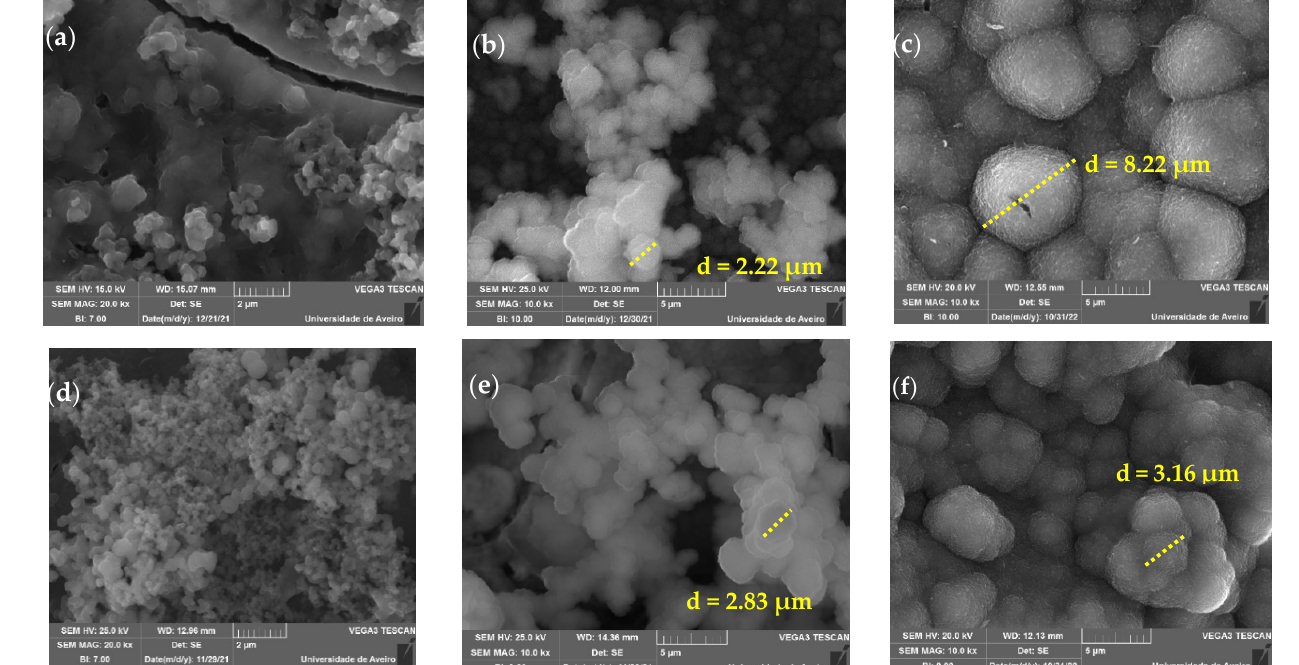
Figure 6. SEM images of glass pellets after 24 h, 96 h, and 336 h of immersion in SBF ( a ) Base 24 h; ( b ) Base 96 h; ( c ) Base 336 h; ( d ) Ce2 24 h; ( e ) Ce2 96 h and (f) Ce2 336 h.